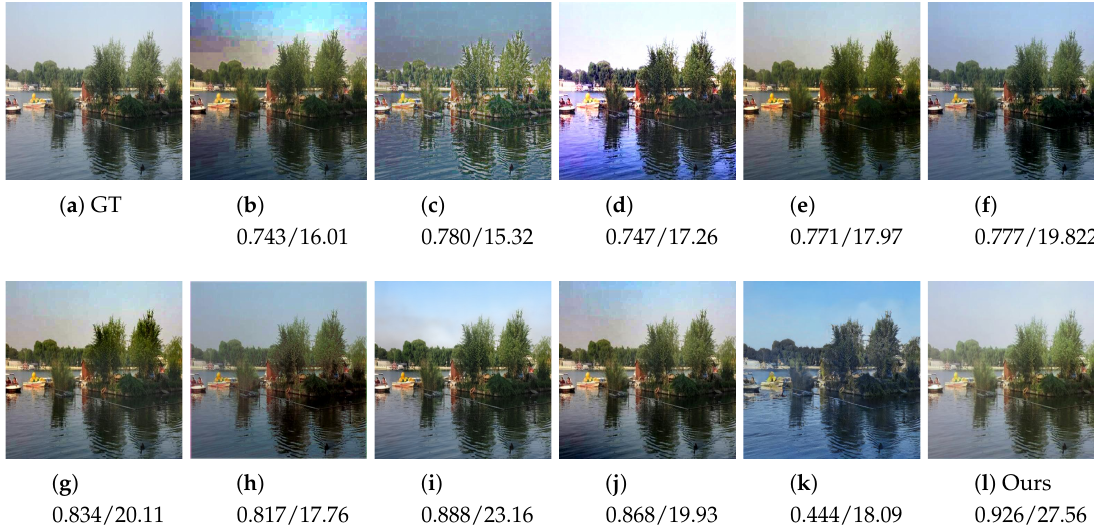
Figure 9. Comparison in terms of SSIM/PSNR for different image dehazing methods. ( a ) Ground Truth. ( b ) DCP. ( c ) FVR. ( d ) BCCR. ( e ) CAP. ( f ) DehazeNet. ( g ) MSCNN. ( h ) AOD-Net. ( i ) dehaze-cGAN. ( j ) Proximal. ( k ) CycleGAN. ( l )